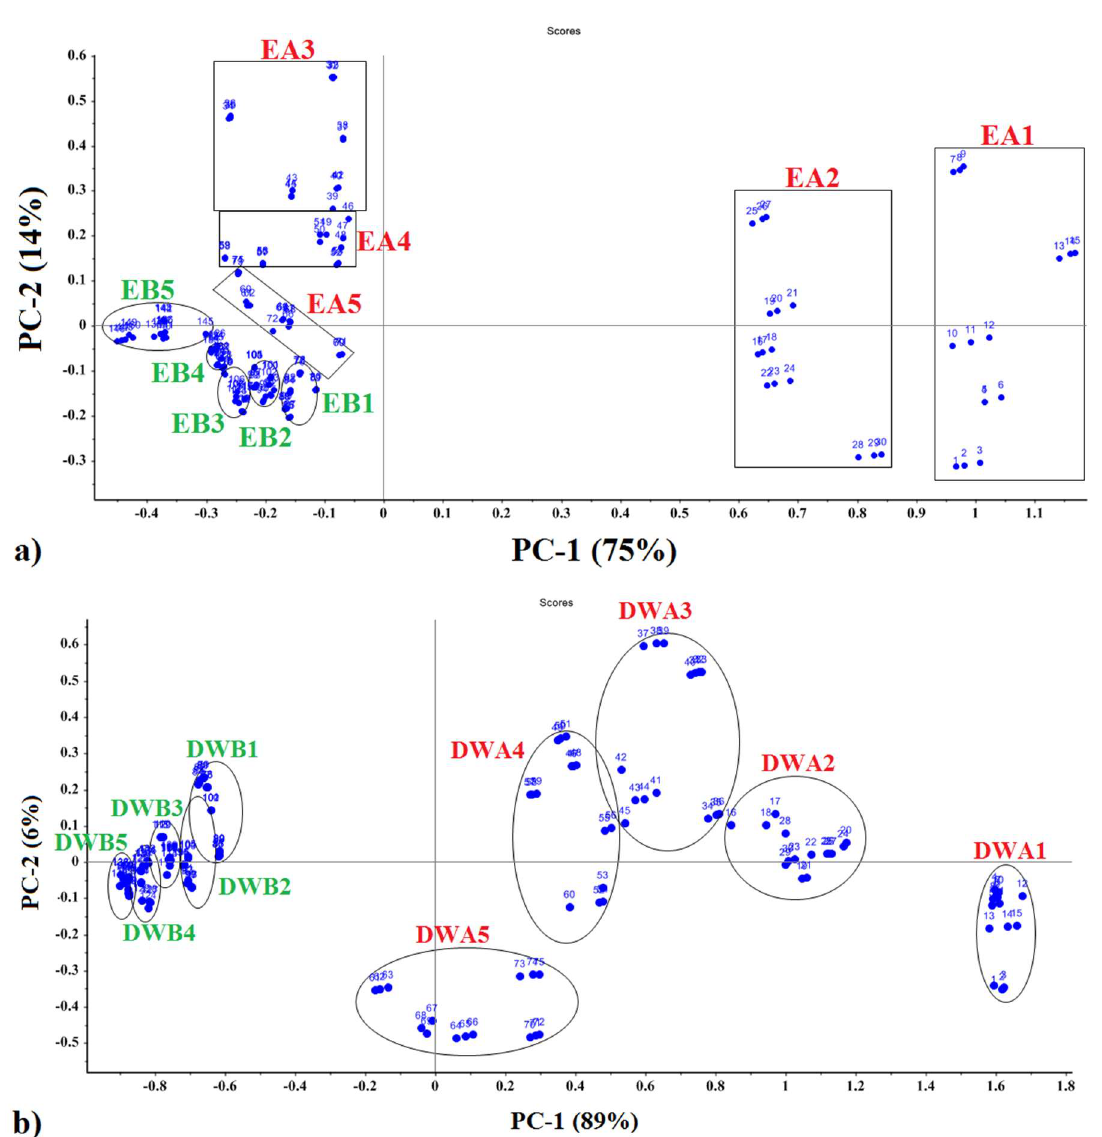
Figure 4. Two-dimensional PCA plot to ( a ) mint EO, and ( b ) mint DWE with data collected using an e-nose.